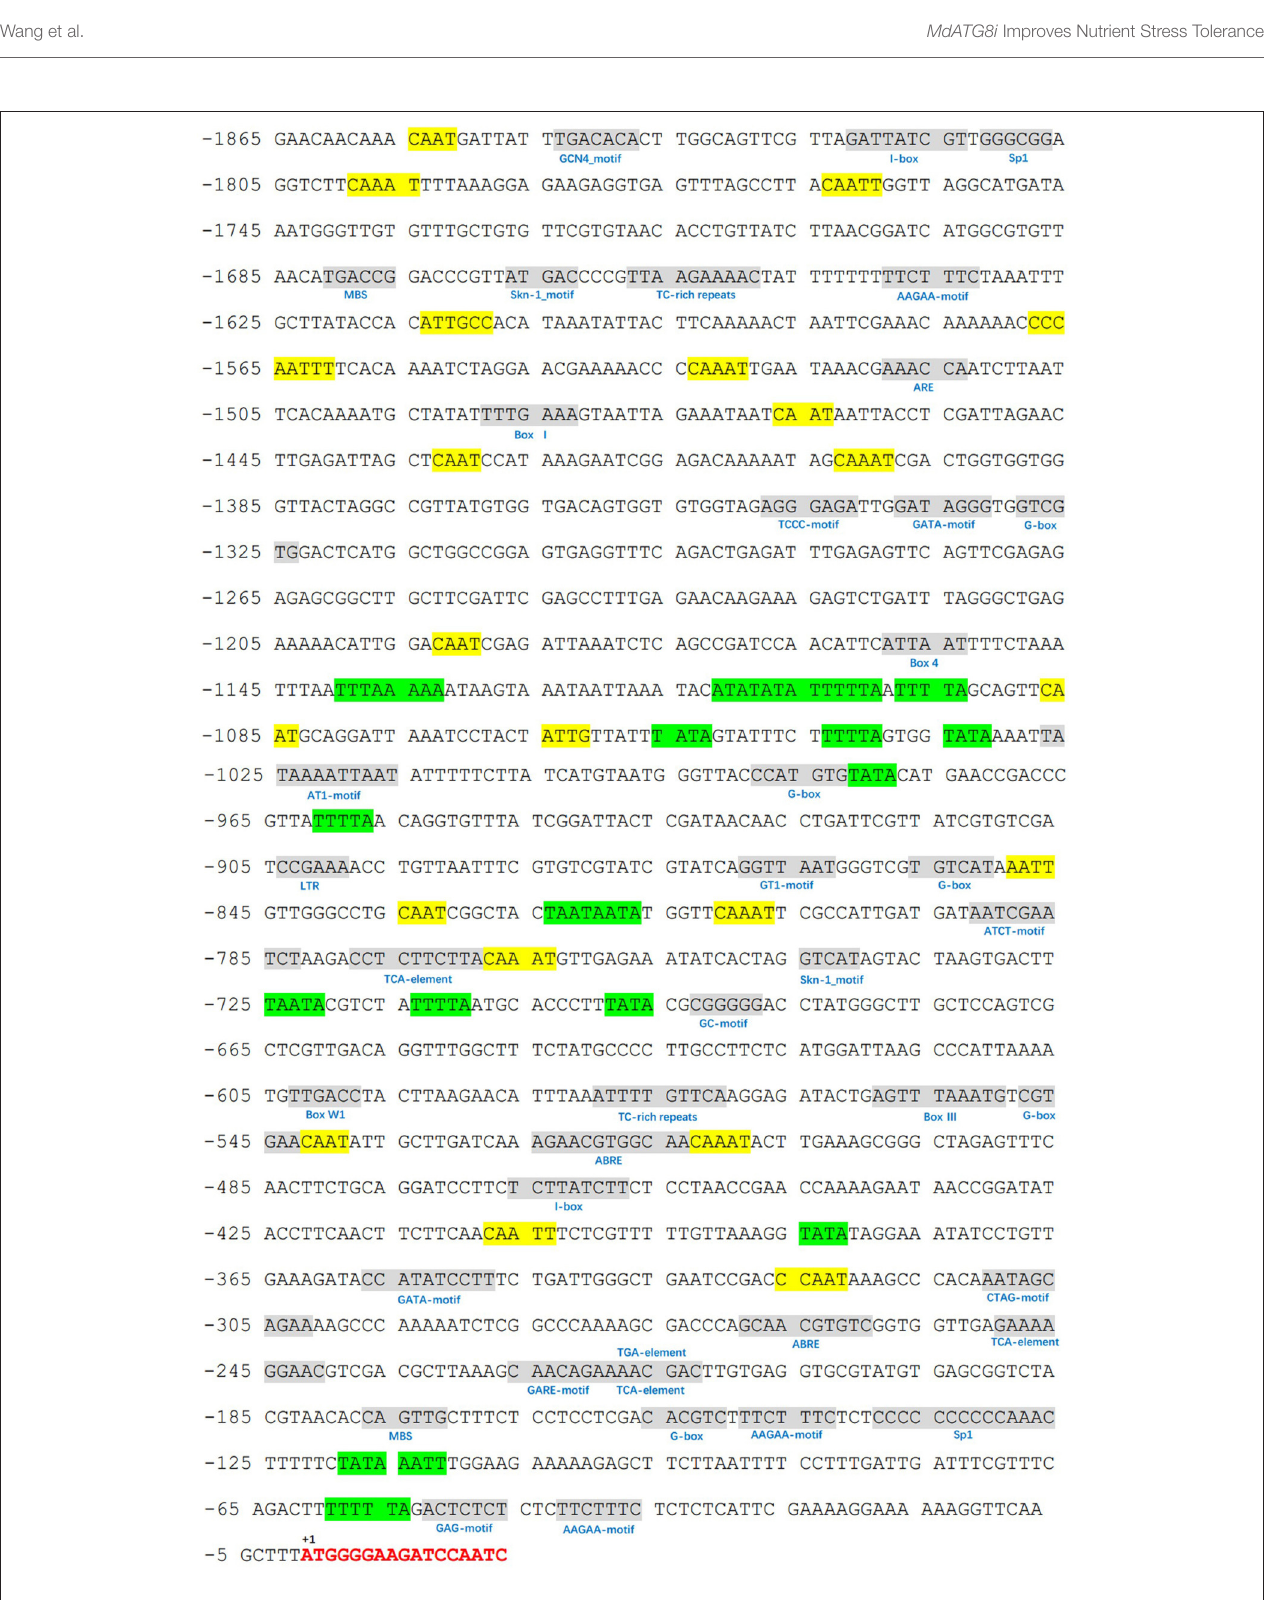
FIGURE 3 | Putative cis -regulatory elements (shaded in gray) in promoter region of MdATG8i , as predicted from PlantCARE database. A 1865-bp fragment was cloned from apple genome DNA, with a GenBank Accession Number KU379689. Key sequence elements—TATA box and CAAT box—are shaded in green and yellow, respectively. Letters in red indicates the coding sequence of MdATG8i